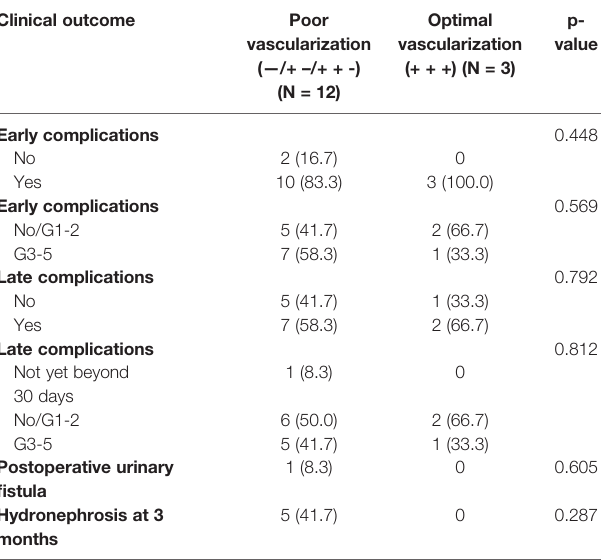
TABLE 3 | Correlation between indocyanine green (ICG) perfusion of all anastomoses* and clinical outcomes. Clinical outcome Poor